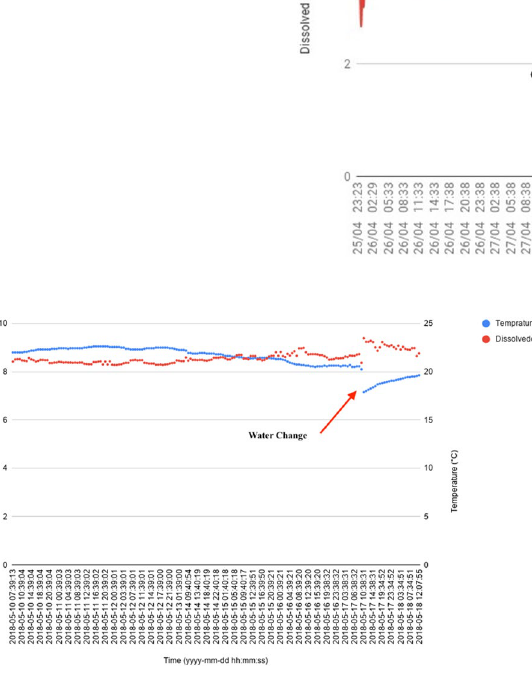
Fig. 12 pH data from multi-sensor node while monitoring the Tila- pia experiment